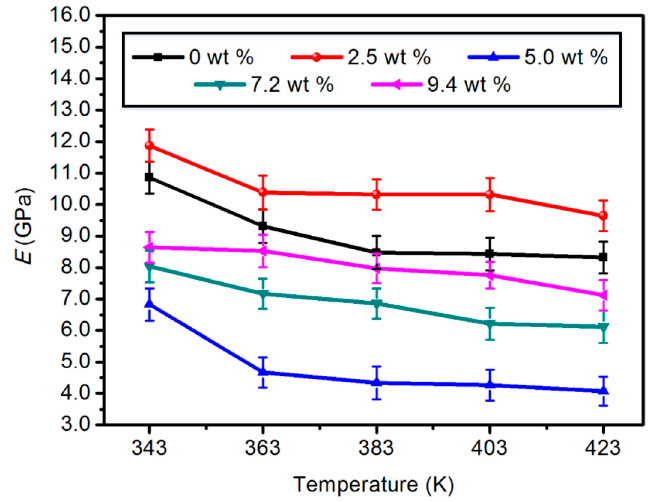
Figure 2. Elastic modulus of five different content composite models.